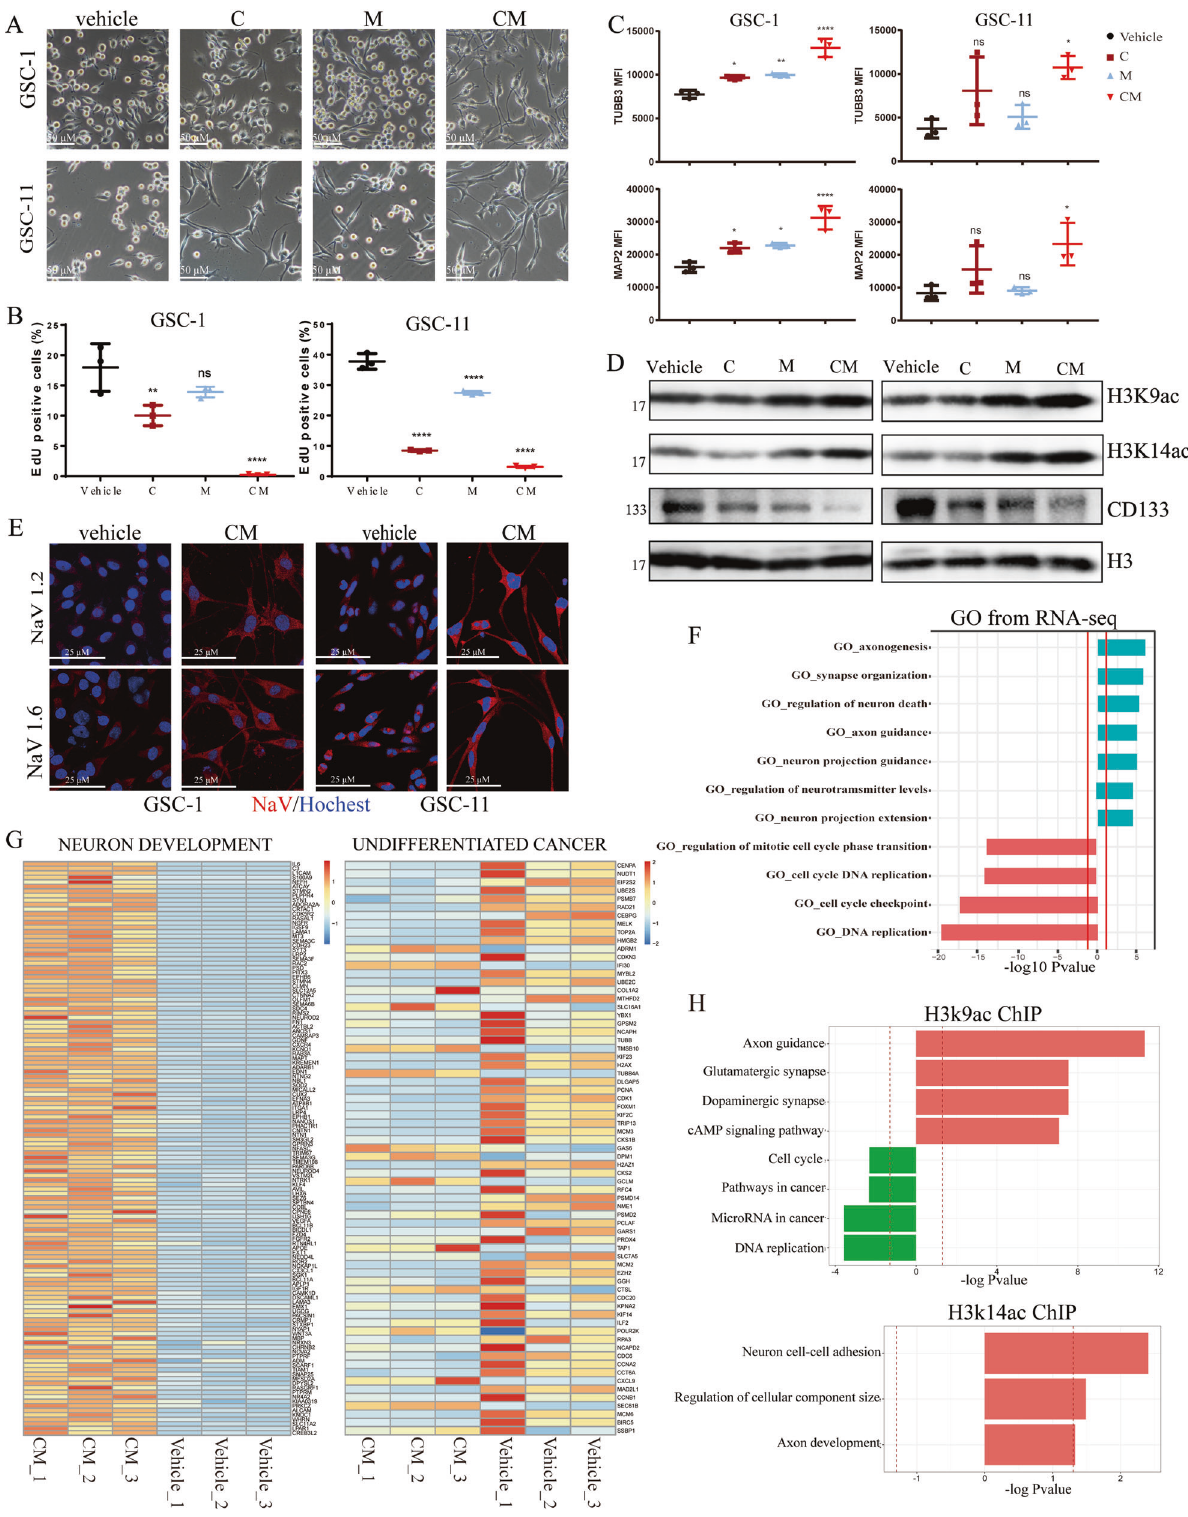
of H3K9ac tags on cell cycle gene in the presence of HDAC1/3 inhibition is clear and provides a good explanation for the almost complete inhibition of proliferation of glioma cells and GSC cells. However, what underlies the opposite change of H3K9ac tags marking on neuronal differentiation gene and cell cycle-related gene is largely unknown and needs a further